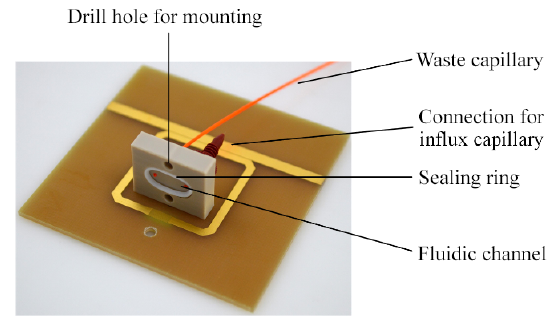
Figure 18. Final layout of the split-ring resonator.